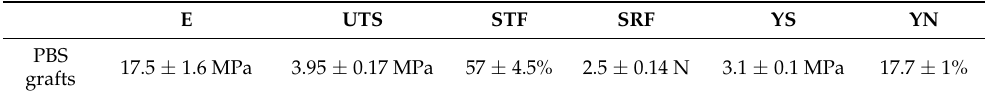
Table 3. parameters obtained from uniaxial tensile test and suture retention test. Table 3. Parameters obtained from uniaxial tensile test and suture retention test.